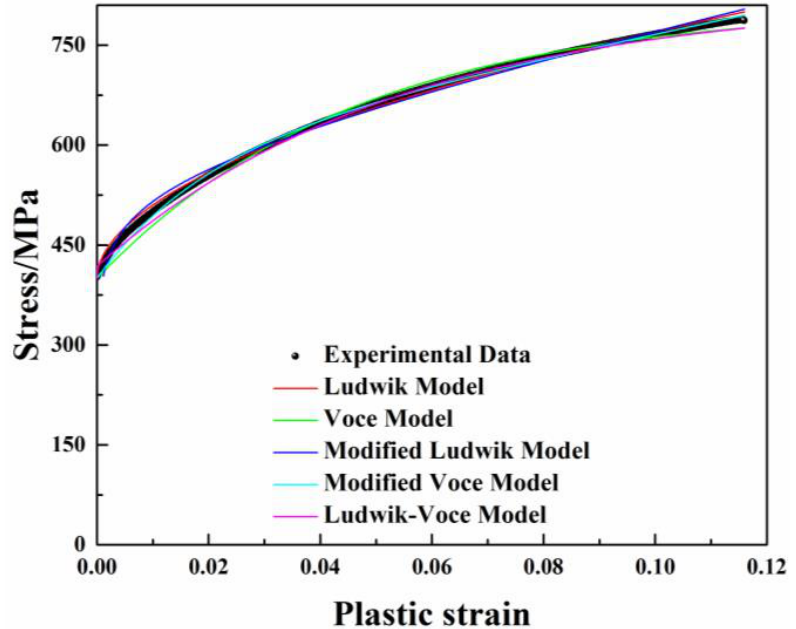
Figure 11. Experimental data and fitting curves of strain models. Table 3. Equations of strain models.